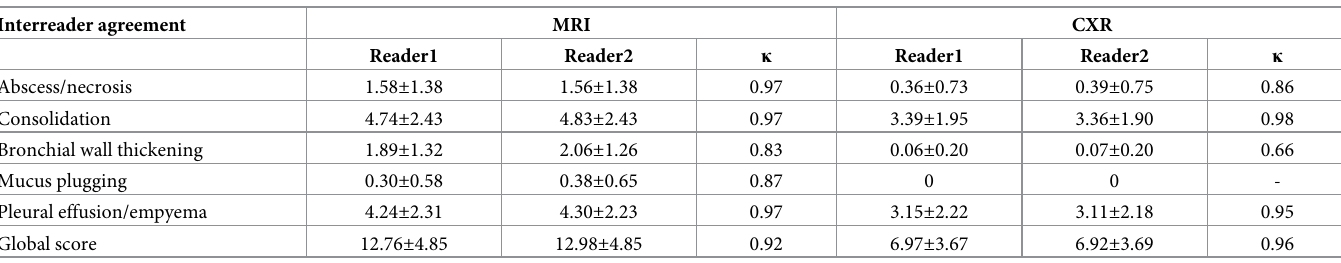
Table 3. Inter-reader agreement for MRI and CXR scores.